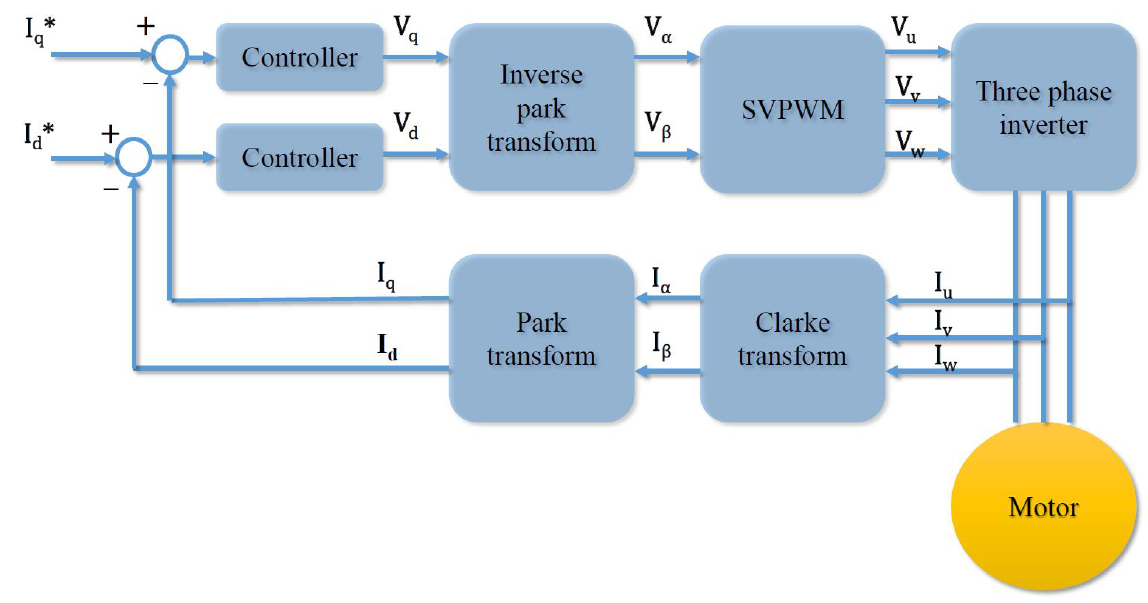
Figure 10. Block diagram of the developed motor-driven system of the LLRE-II.